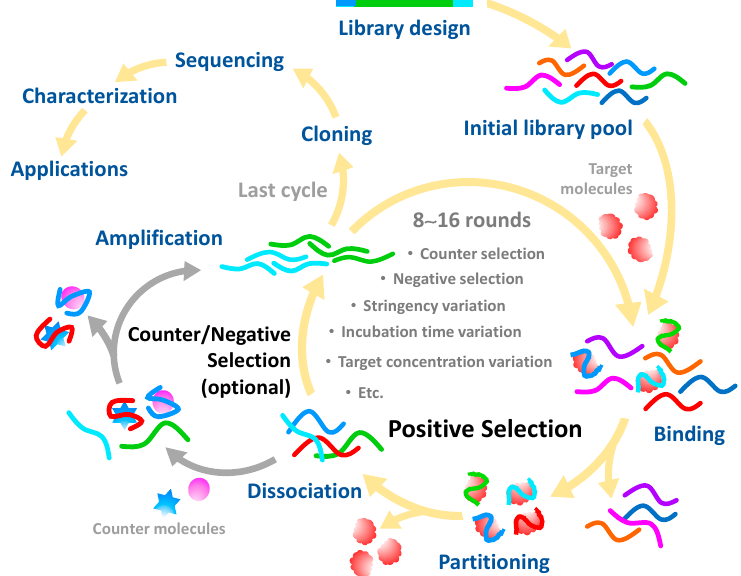
Figure 1. Typical steps of the systematic evolution of ligands by exponential enrichment (SELEX) procedure.